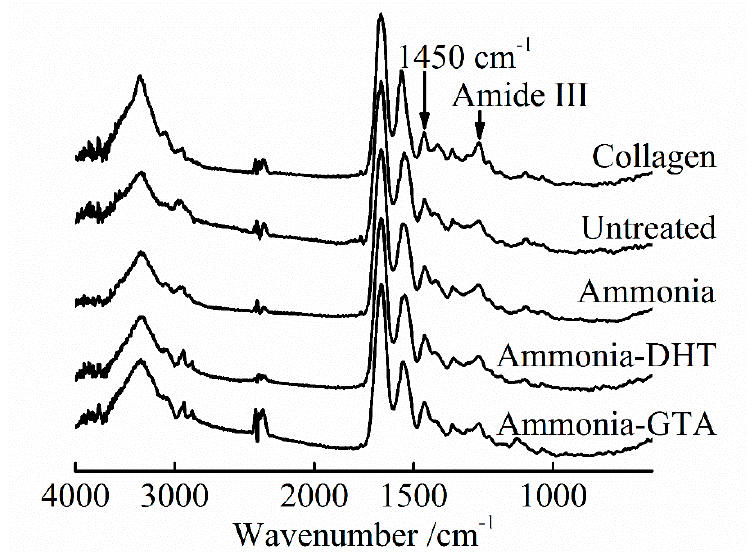
Figure 3. FTIR-ATR spectra of original lyophilized collagen and electrospun collagen tubes before and after various treatments.